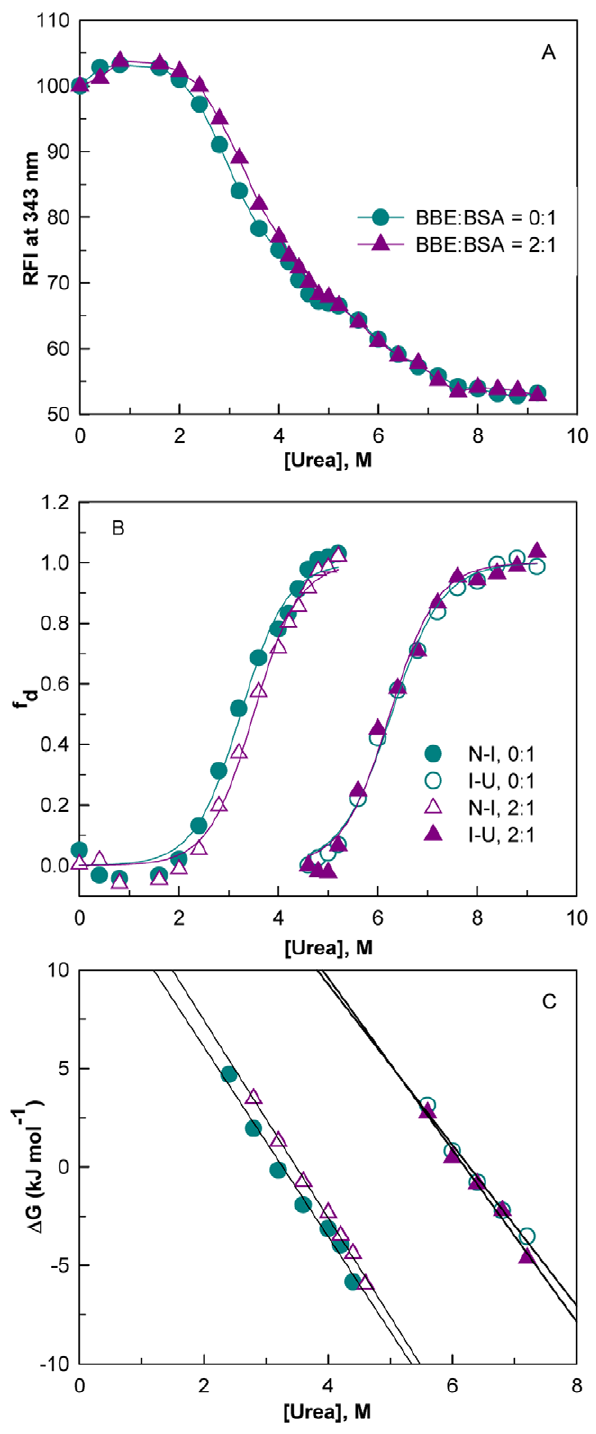
Figure 7. The equilibrium unfolding process and stability of BBE-BSA complex. The urea-induced unfolding profile of BSA and BBE-BSA complex at BBE/BSA molar ratios of 0:1 and 2:1 monitored by intrinsic fluorescence of the protein (A). The fraction denatured (f d ) versus [urea] plots for N = I and I = U transitions of the protein and complex. Lines represent the nonlinear regression fitting of the data according to equation 7 (B). The dependence of free energy change as a function of urea concentrations for the transitions shown in Figure B